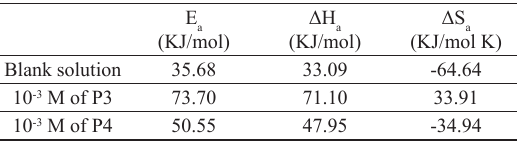
Table 5. Values of activation and thermodynamic parameters for ordinary steel in 5.0 M HCl without and with 10 -3 M of P3 or P4.